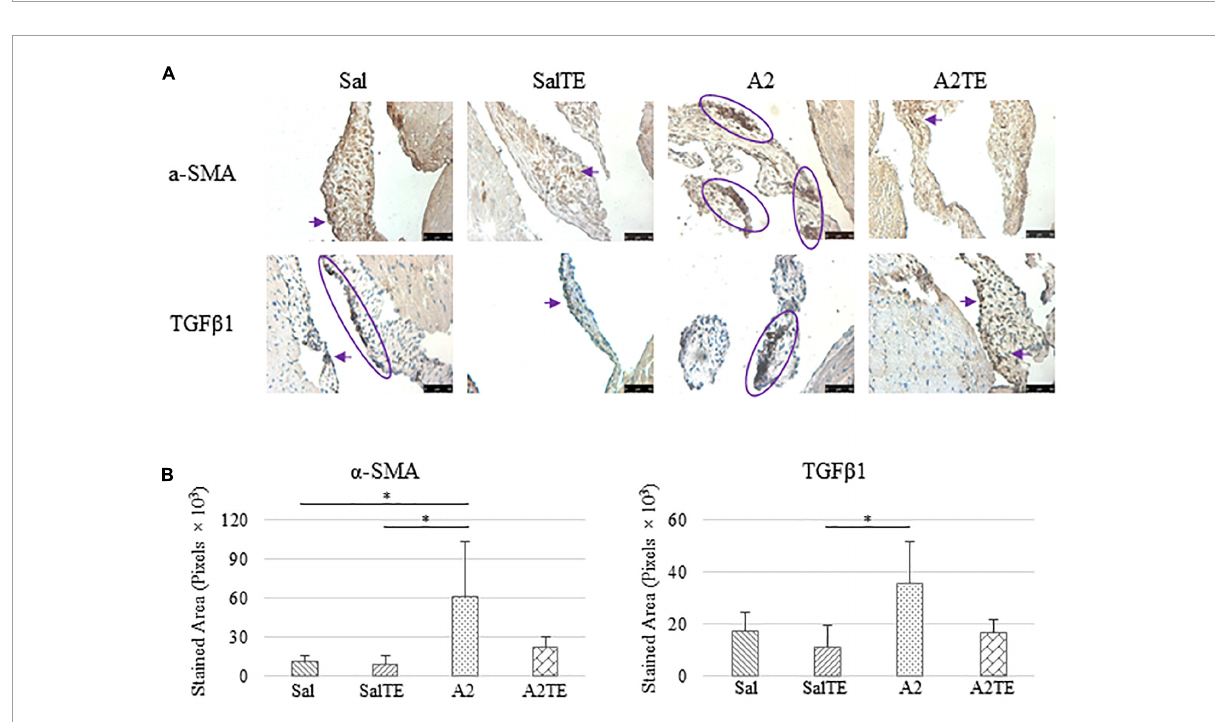
FIGURE6 (A) Investigation of mitral valve VIC activation by IHC examinations on α -SMA and TGF β 1 in prevention study. Major positive IHC stains were highlighted by circles and arrows. Scale bar: 50 µ m. (B) Quantification of their expression determined by total stained area in pixels that measured from 4 biological replicates in MATLAB. Asterisk indicates significant difference ( p <